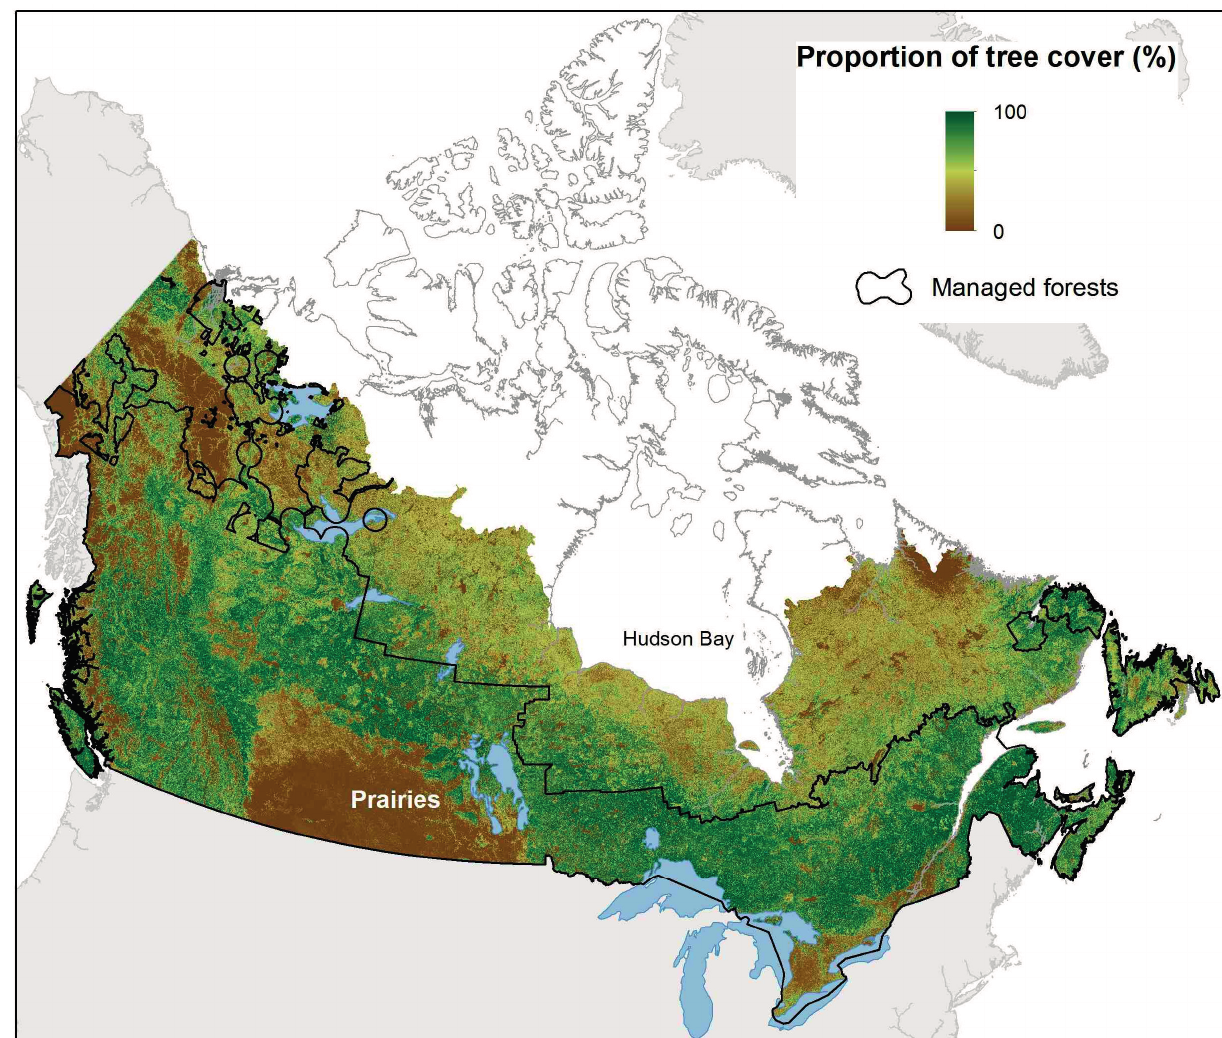
Figure 1. Current extent of the managed forests within Canada (see text for definitions), along with the percentage of tree cover estimated for year 2001 (based on